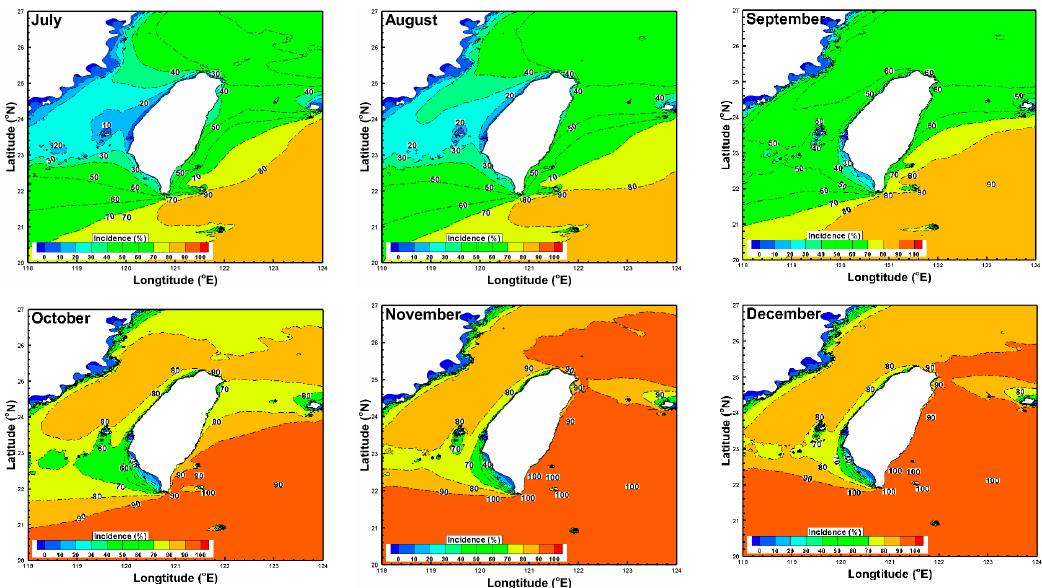
Figure 12. Spatial distributions of the monthly average incidence of the wave power exceeding 4 kW/m in the offshore waters of Taiwan from 1991 to 2010.